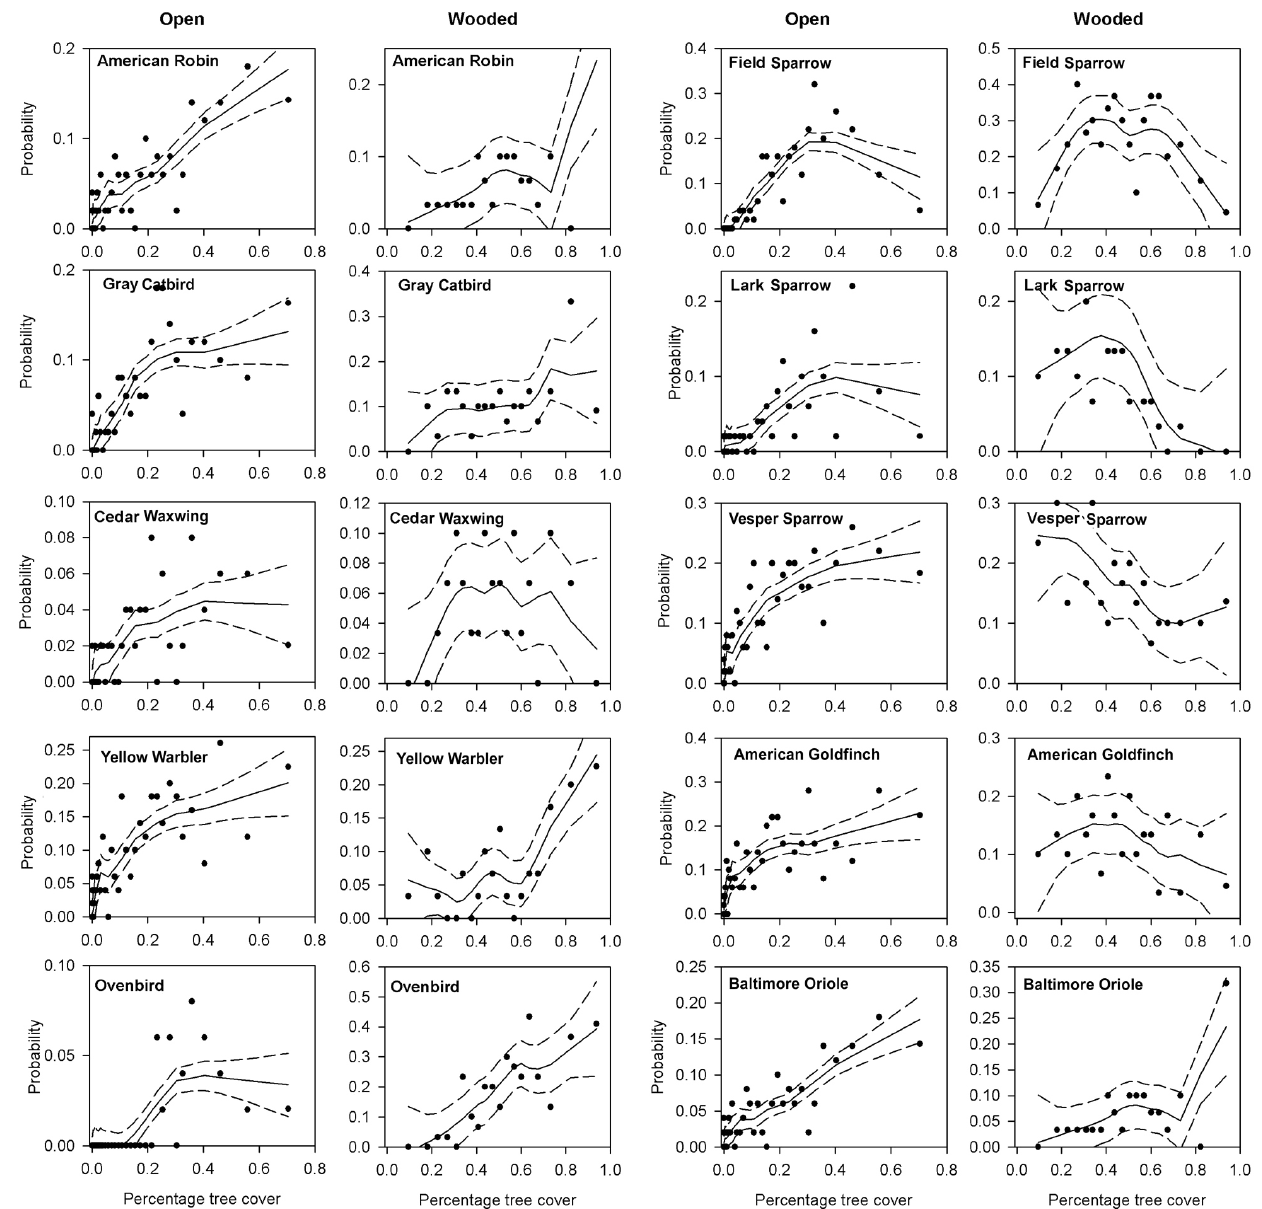
Fig. 5 . Comparison of responses (estimated probability of occurrence) to site-scale tree cover in open and wooded landscapes. Ten of 22 species analyzed are shown. For explanation see Figure 4. Some species were mostly absent from open landscapes, e.g., Ovenbird ( Seiurus aurocapilla ) or from heavily wooded landscapes, e.g., Baltimore Oriole ( Icterus galbula ). For species’ scientific names, see Table